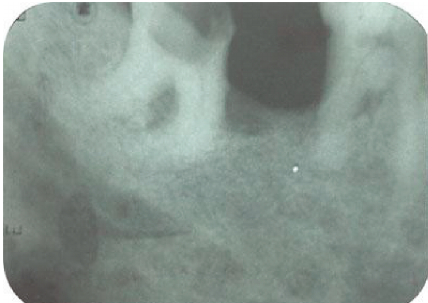
Figure 1: Diagnostic radiograph showing severely curved canals.